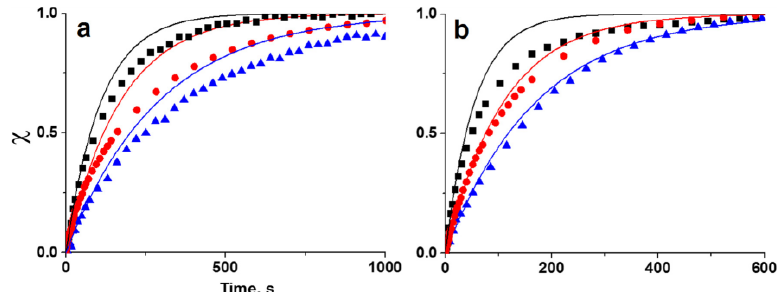
Figure 5. Dynamics of methanol adsorption ( a ) and desorption ( b ) in the compact carbon bed glued with the grease ( ■ ), the loose compact layer ( ▲ ), and the reference granulated bed ( ● ). Grain size D gr = 1.6–1.8 mm. Reprinted/adapted with permission from Ref. [72]. (Copyright 2017), Elsevier.